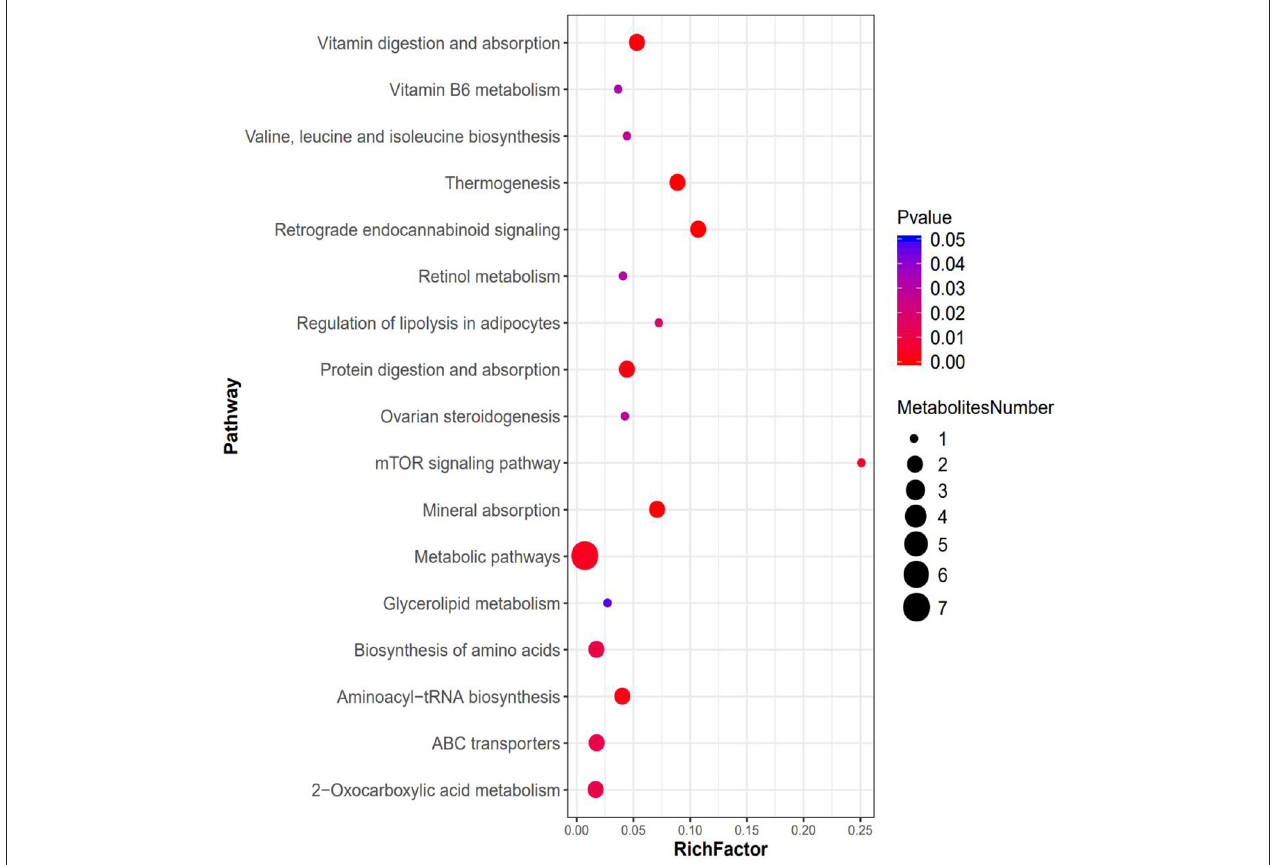
FIGURE 6 | Bubble plots for metabolic pathway enrichment analysis between the ACE and CORT group ( n = 6 per group). X-axis enrichment factor (RichFactor) is the number of differential metabolites annotated to the pathway divided by all identified metabolites annotated to the pathway. The larger the value, the greater the proportion of differential metabolites annotated to the pathway. The dot size represents the number of differential metabolites annotated to this